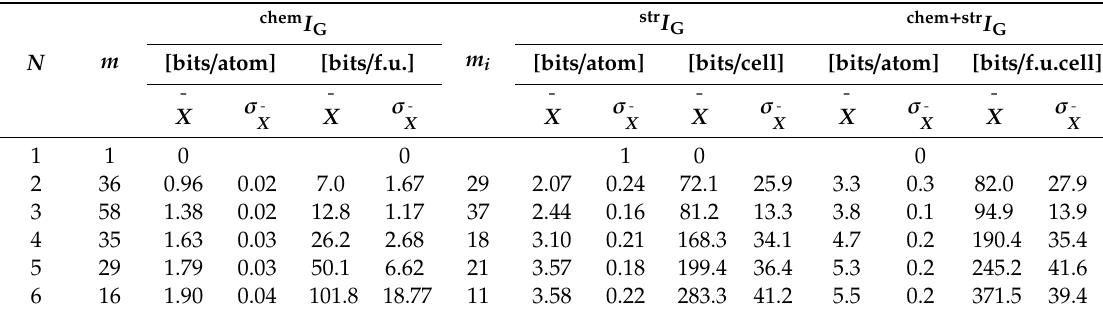
Table 3. Chemical, structural, and crystallochemical (chem + str) complexities of tellurium minerals according to the number of species-defining chemical elements ( N ) *.